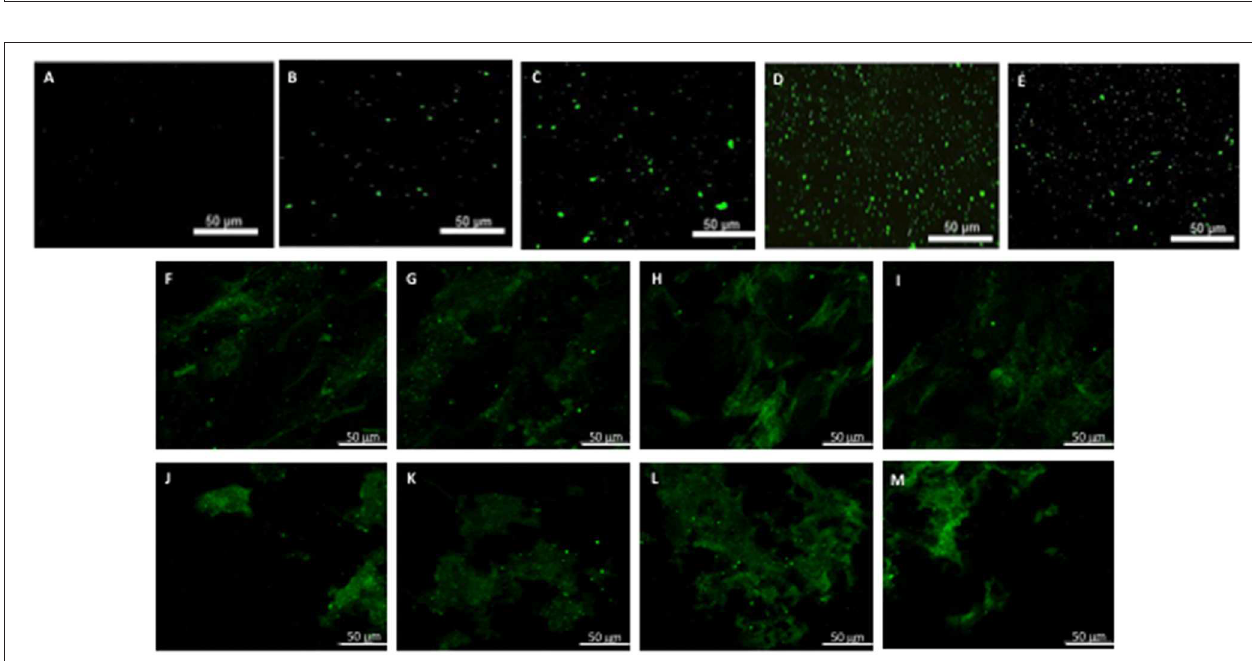
FIGURE 6 | hBM-MSCs differentiation toward CD31 phenotype. PGA-PLLA scaffolds seeded with hBM-MSCs (5) demonstrated the presence of CD31 phenotype in (A) static, (B,C) flex-flow, and (D,E) PHV groups; the same cell-seeded scaffolds from our experiments focusing on (F–I) static and (J–M) physiologically-relevant oscillatory flow groups demonstrate the presence of CD31 phenotype. Image magnification of 72X.